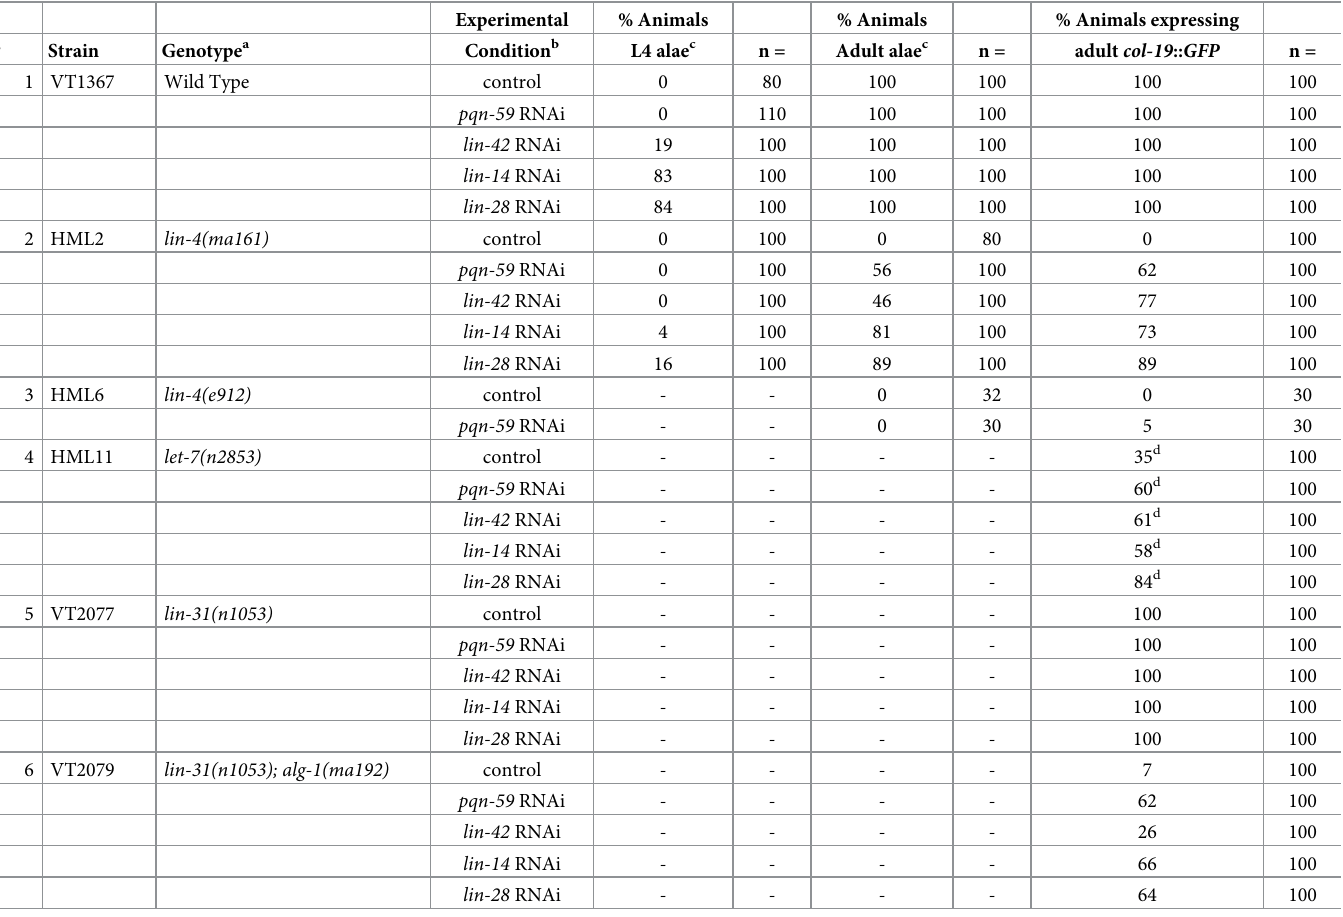
Table 1. Measurement of RNAi-mediated suppression of temporal patterning phenotypes of various heterochronic mutants. Experimental % Animals % Animals % Animals expressing # Strain Genotype a Condition b